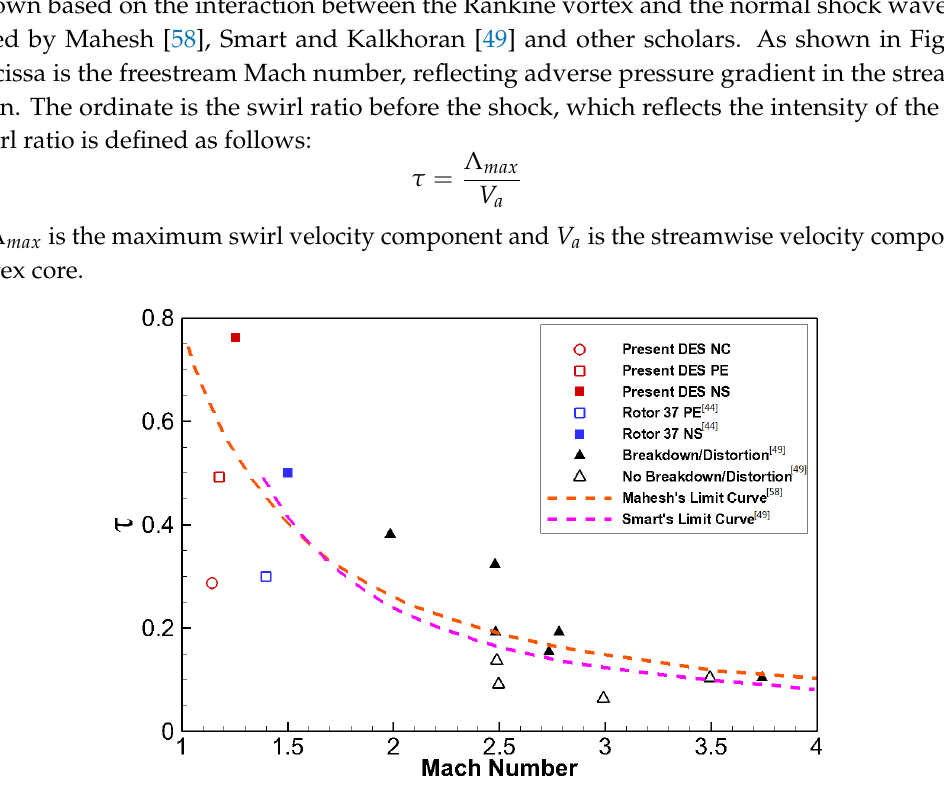
Figure 22. Limit curve for normal shock wave/vortex